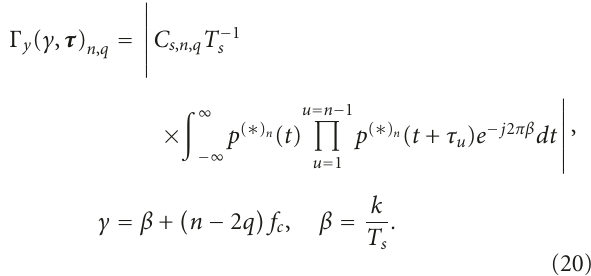
where ( ∗ ) represents the one of q total conjugations. For the case of n = 2, q = 1, τ 1 = τ/ 2, and τ 2 = − τ/ 2, the TMF reduces to the autocorrelation function defined in (3).